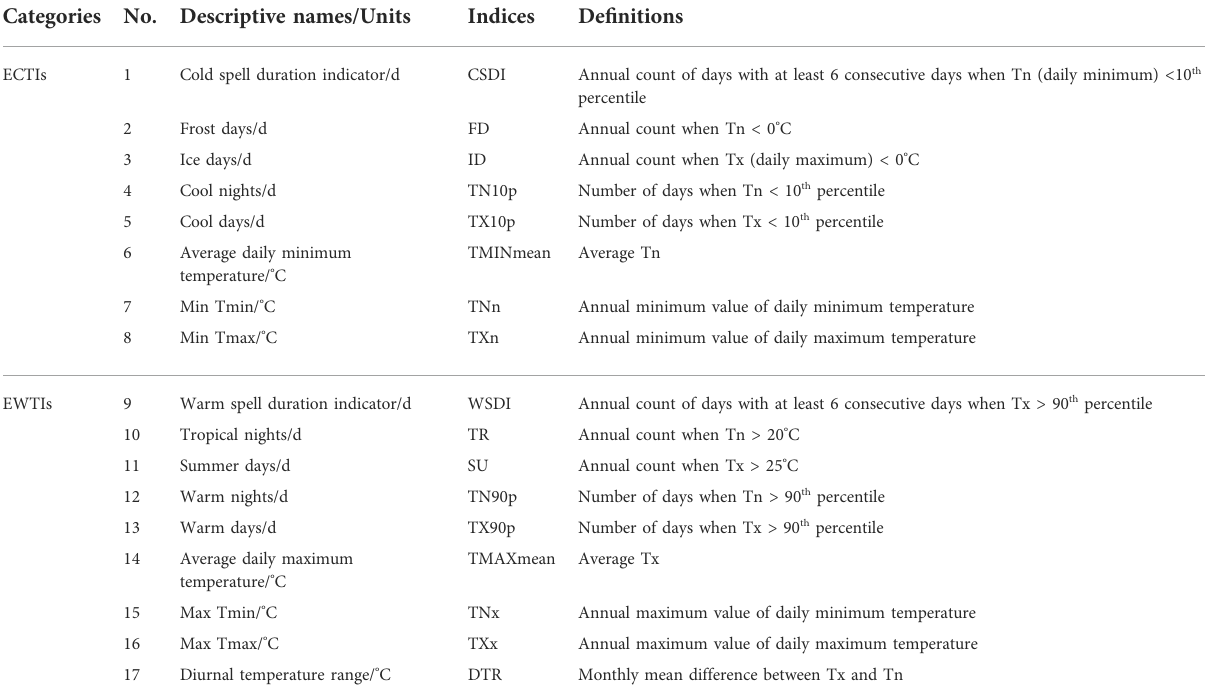
TABLE 2 List of the 17 selected ETIs. Categories No. Descriptive